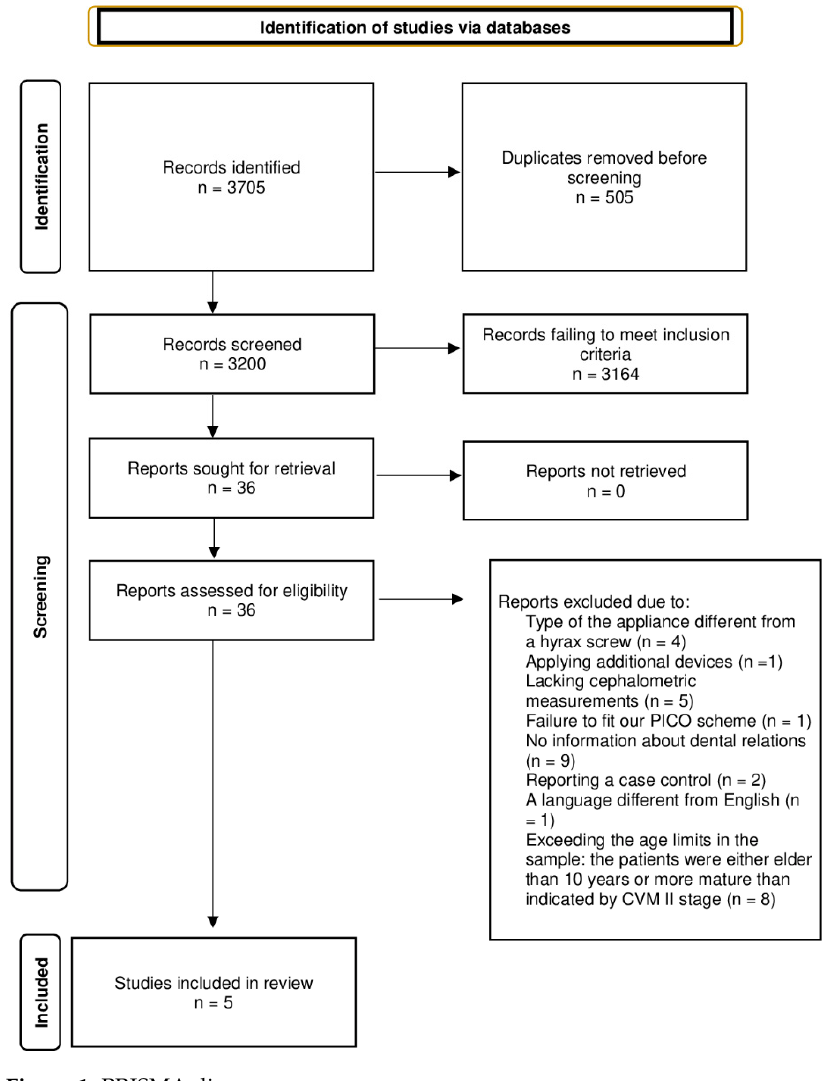
Figure 1. PRISMA